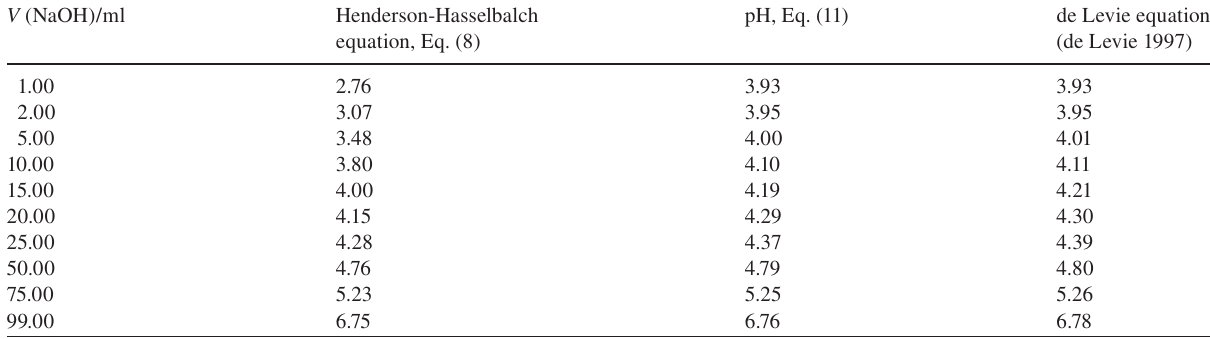
COOH with 0.0010 M NaOH). 3